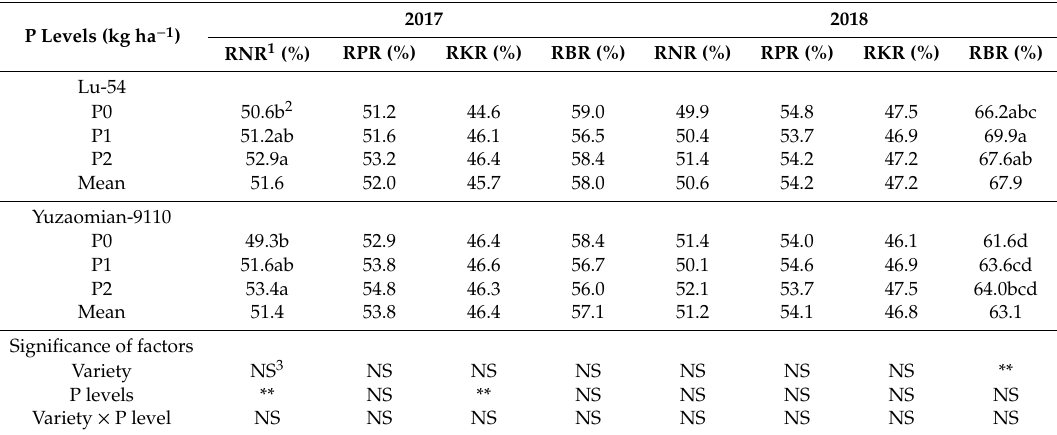
Table 6. Total N, P, K, and biomass percentage allocation in reproductive organ for Lu-54 and Yuzaomian-9110 in 2017 and